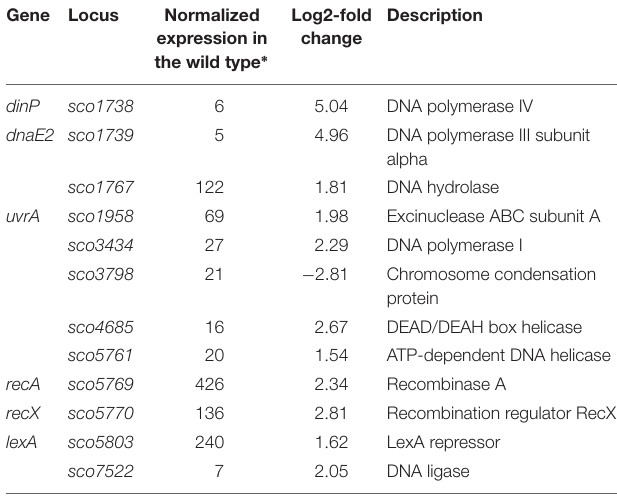
TABLE 6 | DNA processing and DNA repair genes impacted by constitutive topA -upregulation (based on RNA-Seq data; log2-fold > 1.5; p < 0.05). Gene Locus Normalized Log2-fold Description expression in change the wild type ∗